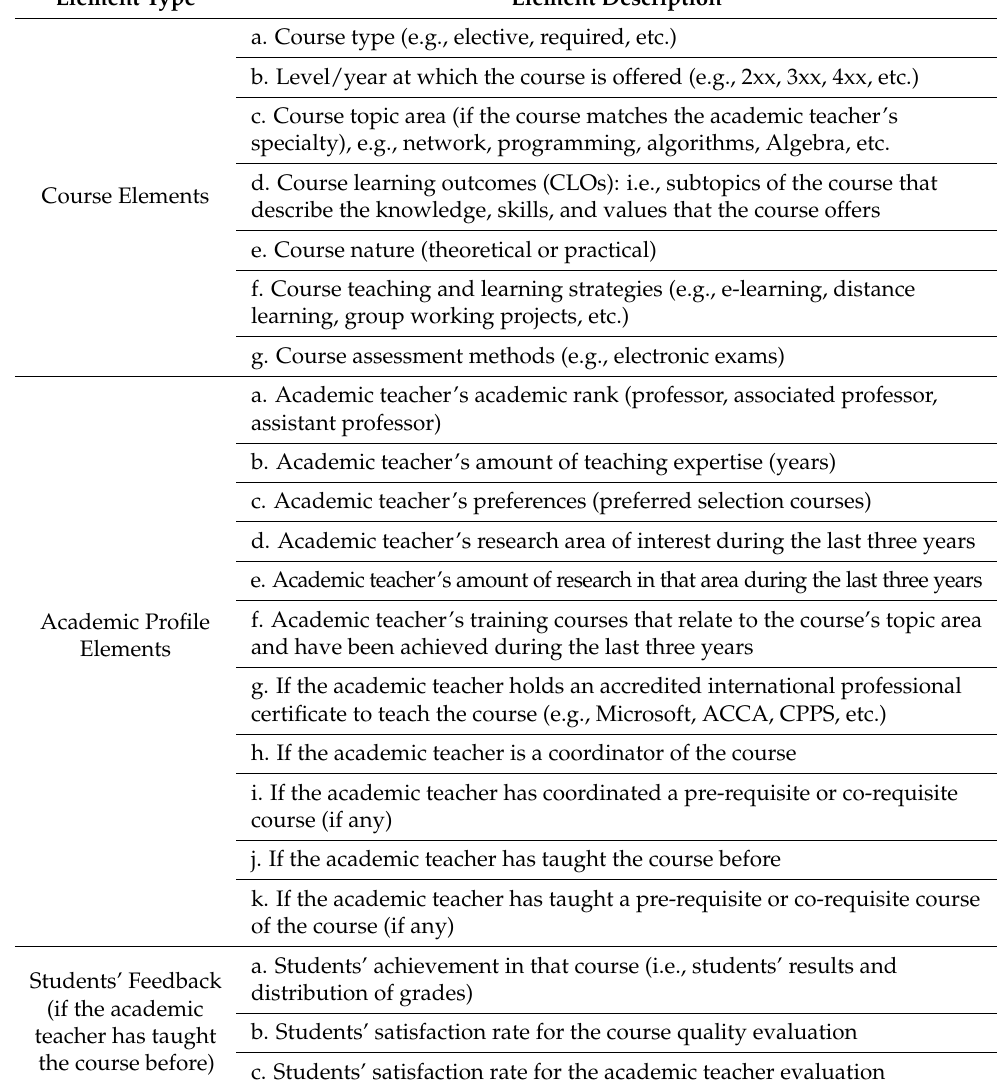
Table 1. Survey elements